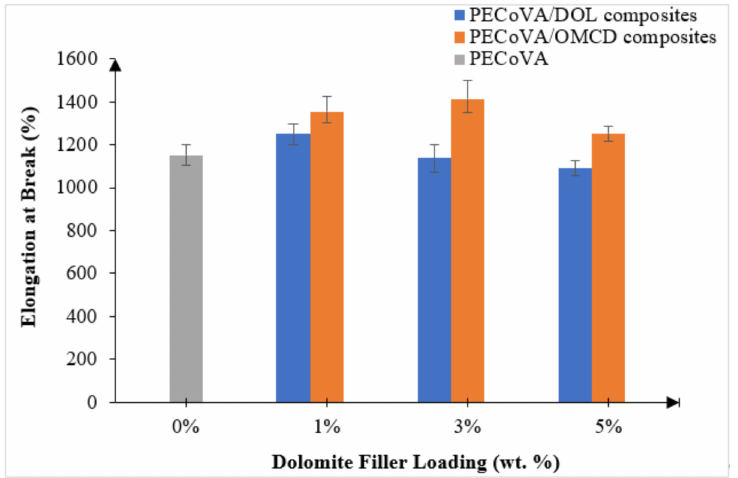
Figure 7. Effect of dolomite filler loading on the elongation at break of virgin PECoVA, PECoVA/DOL and PECoVA/OMCD